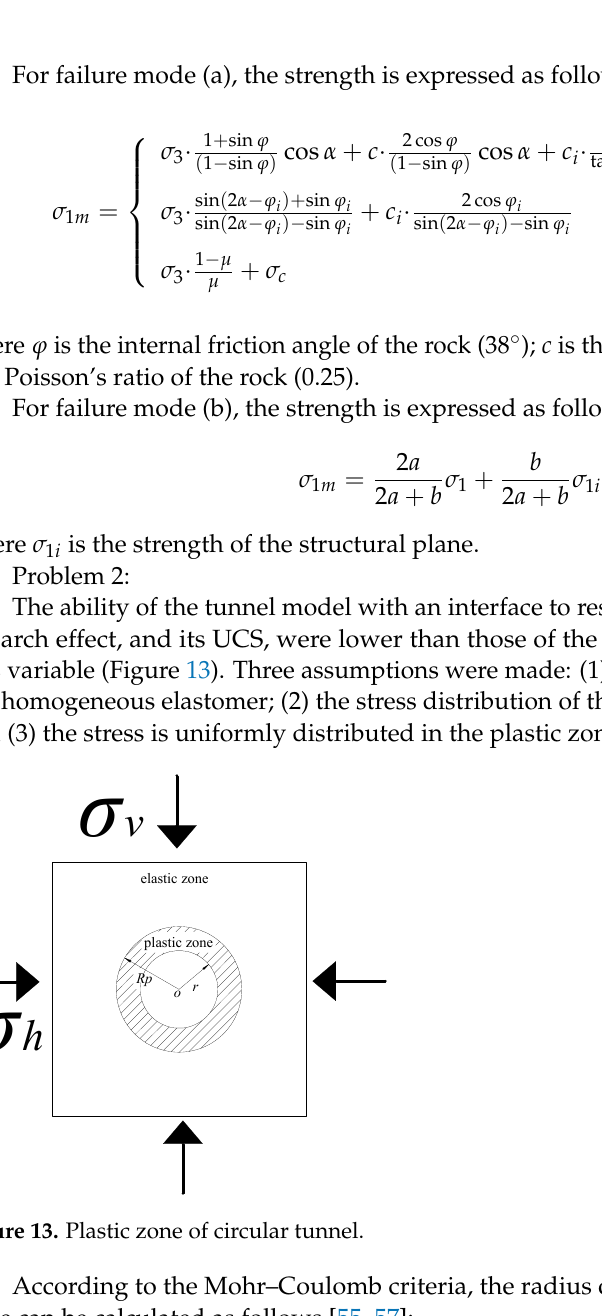
Figure 12. Failure modes. ( a ) regards the sample with below 45 ° dip angle of structural plane, ( b ) regards the sample with above 45 ° dip angle of structural plane.